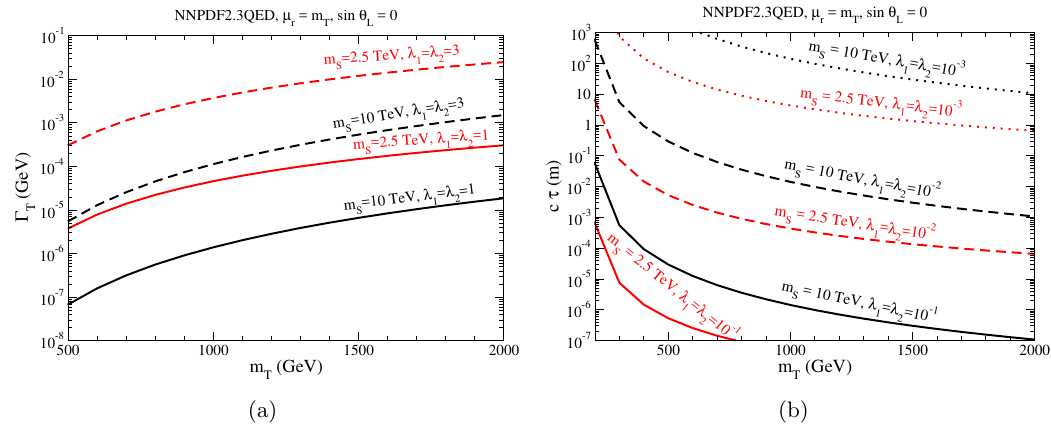
Figure 11 . (a) Total width of top partner and (b) decay length of top partner for sin (cid:18) L = 0. In both (a,b) the scalar mass is (red) m S = 2 : 5 TeV and (black) m S = 10 TeV. In (a) the coupling constants are (dashed) (cid:21) 1 ; 2 = 3 and (solid) (cid:21) 1 ; 2 = 1. In (b) the coupling constants are (dotted) (cid:21) 1 ; 2 = 10 (cid:0) 3 , (dashed) (cid:21) 1 ; 2 = 10 (cid:0) 2 , and (solid) (cid:21) 1 ; 2 = 10 (cid:0) 1 . The renormalization scale is set to the top partner